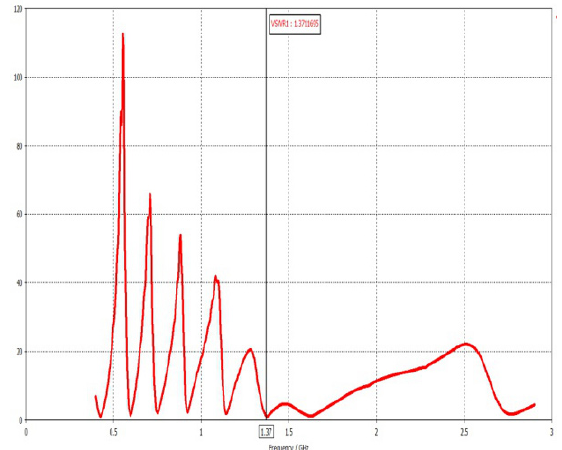
Figure 19. VSWR of Log Periodic Koch Antenna with 60° flare angle Vs. Frequency